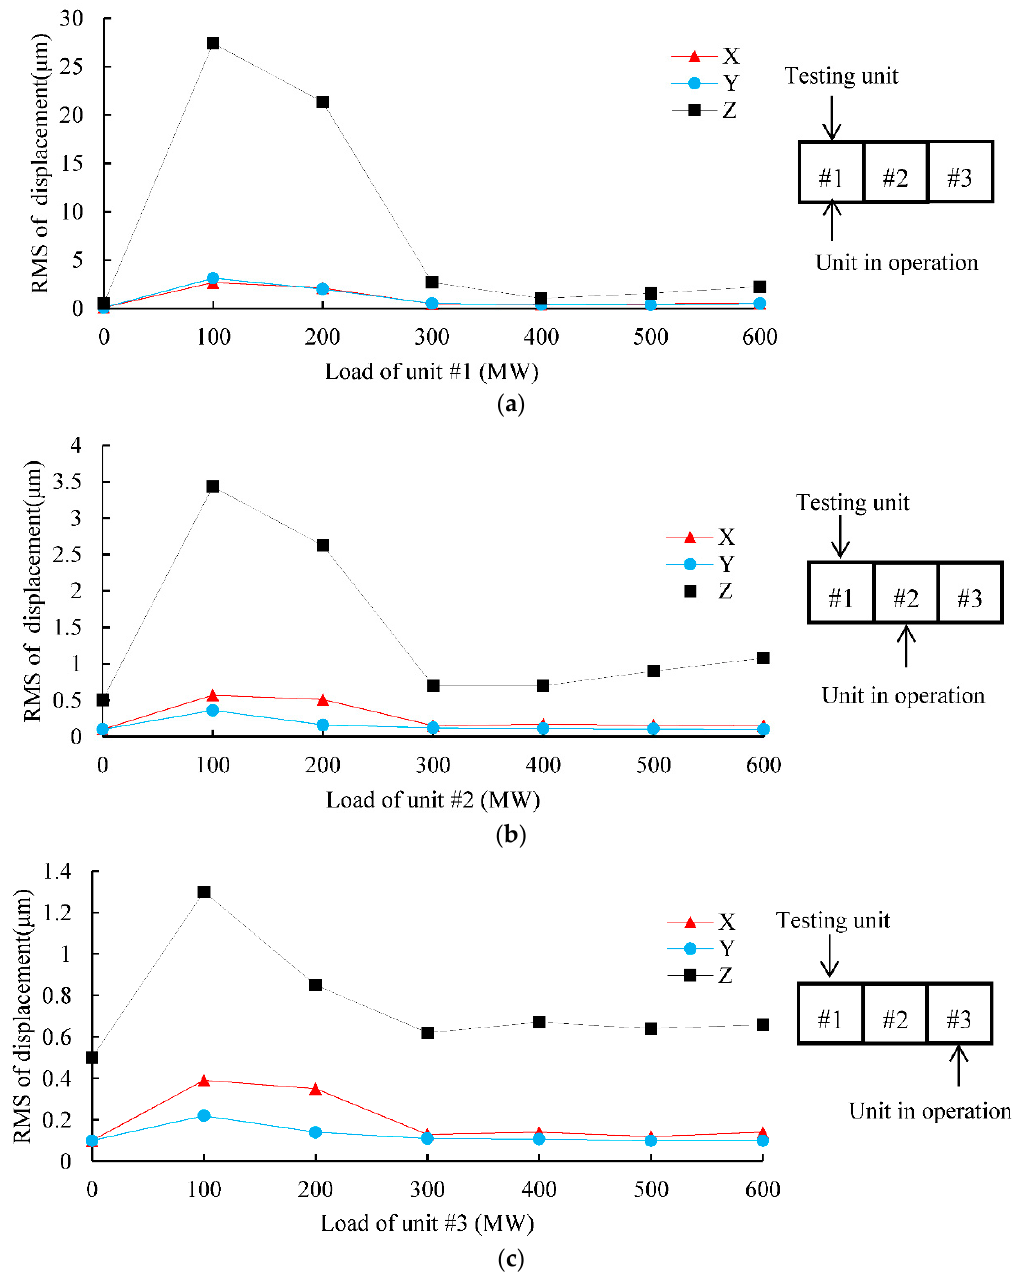
Figure 7. Variation of root mean square (RMS) of displacement with unit #1, unit #2 and unit #3 in operation respectively: ( a ) Unit #1 in operation; ( b ) Unit #2 in operation; and, ( c ) Unit #3 in operation.